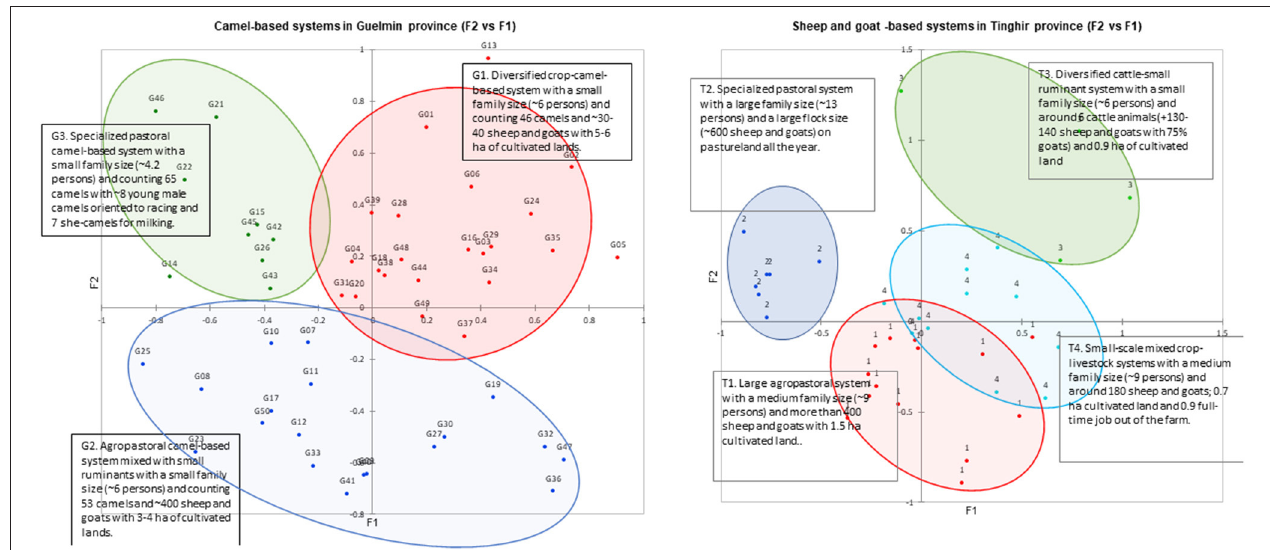
FIGURE 3 | Typology of livestock farming systems in the two studied sites (camel-based systems in Guelmim on the left and sheep and goats farming systems in Tinghir on the right)].